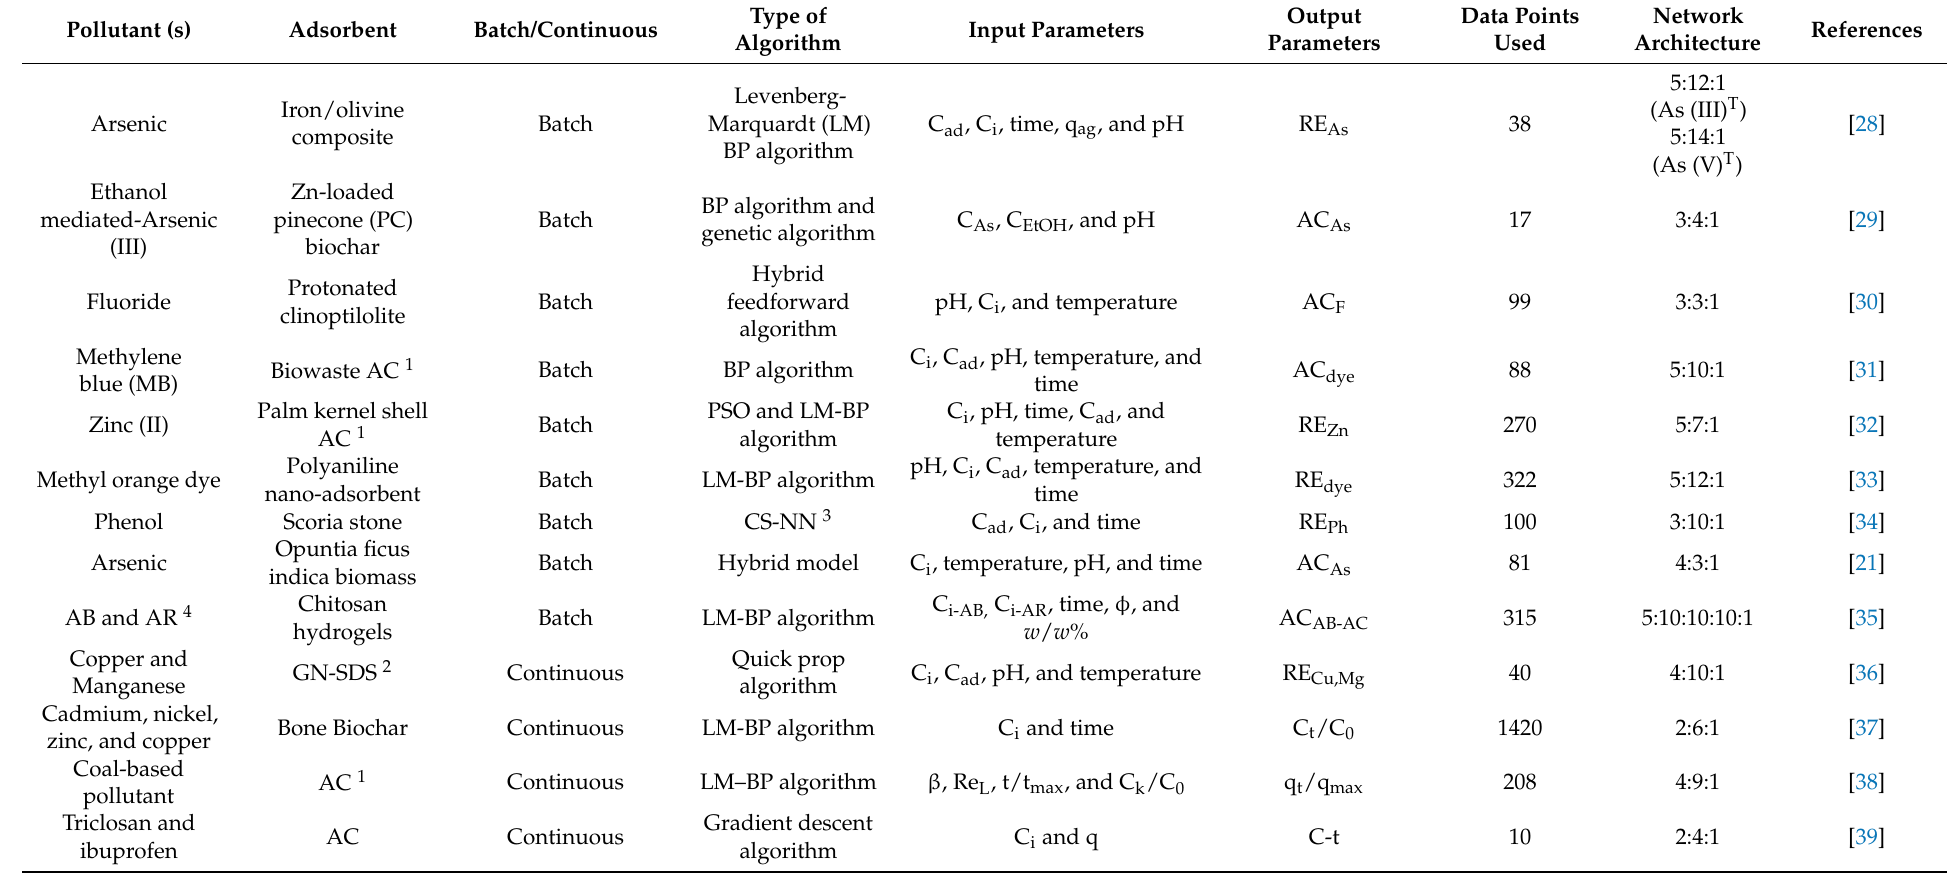
Table 1. Summary of investigations on ANN modeling for different adsorption